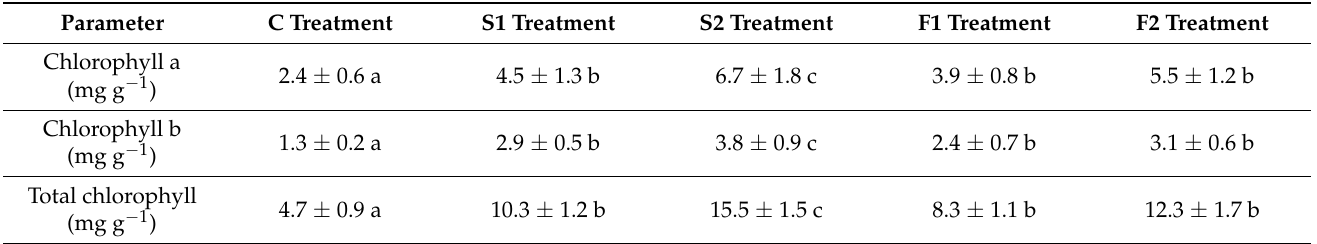
Table 4. Effect of biostimulant obtained from slaughterhouse sludge on chlorophyll a and b content in tomato leaves.